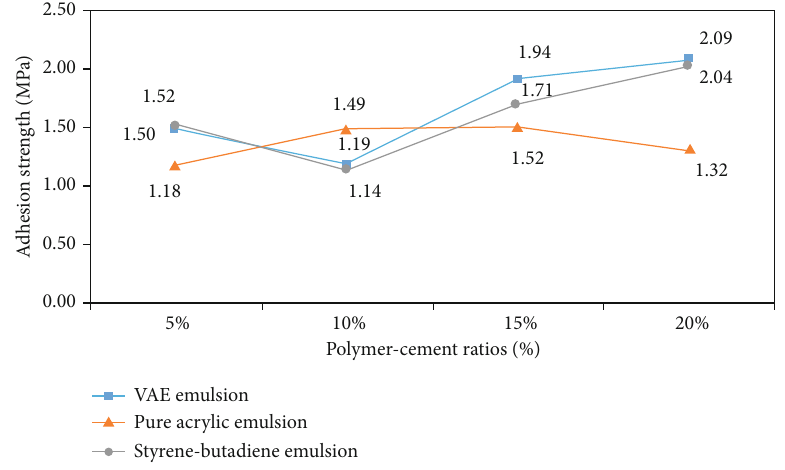
Figure 7: Pull test